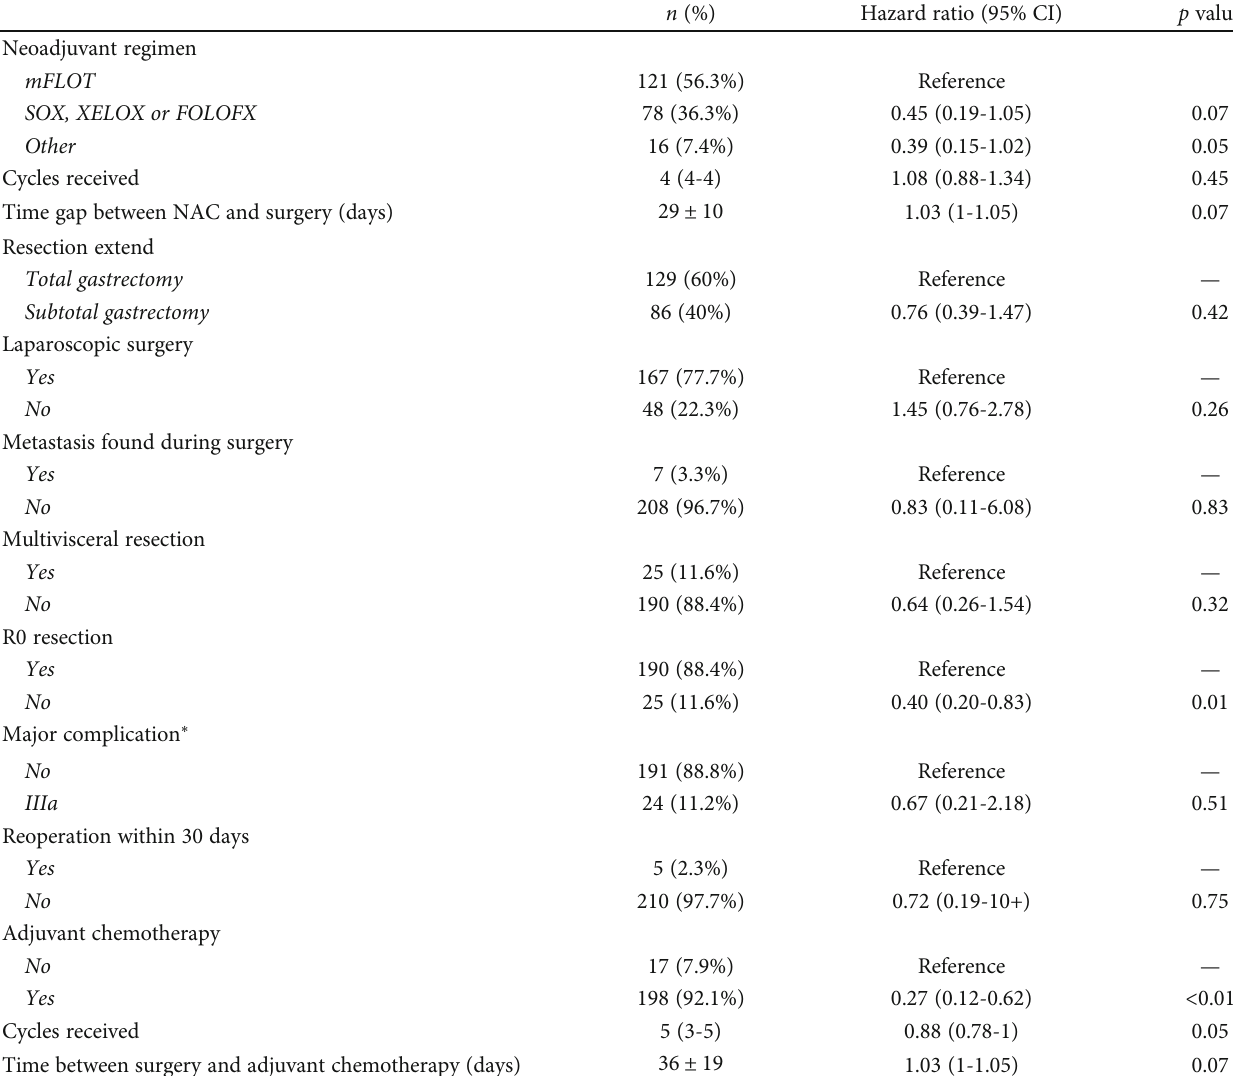
Table 2: Treatment information on chemotherapy and surgery, hazard ratios, and p values from univariable survival analysis ( n = 215